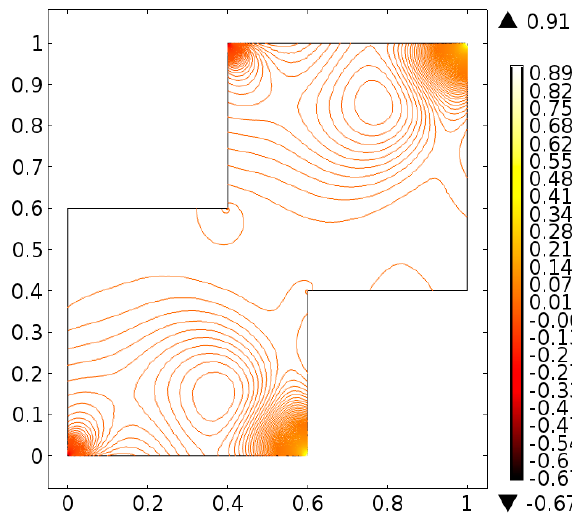
Figure 27. Pressure distribution at Re = 400 for case-II.